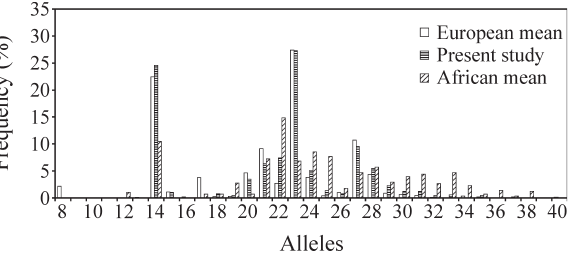
Figure 2 - Allele frequencies of the MJD locus in three population sam- ples. The European and African means were calculated from Rubinsztein et al. (1995); Limprasert et al . (1996); Richards et al . (1996); Jodice et al. (1997); Takano et al .